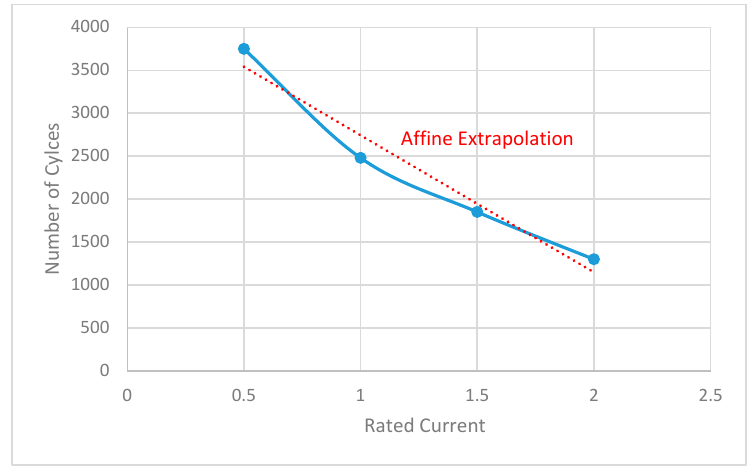
Figure 7. A linear trend extrapolation of SOH according to rated current variation. Energies 2020 , 13 , x FOR PEER REVIEW